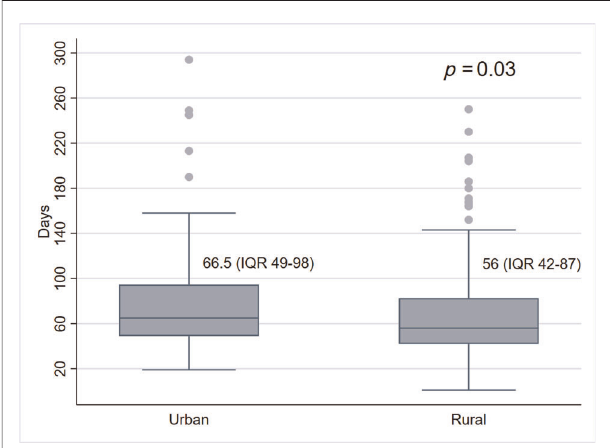
FIGURE 1 | Median fi rst suspected test-operation interval in urban – rural patients.